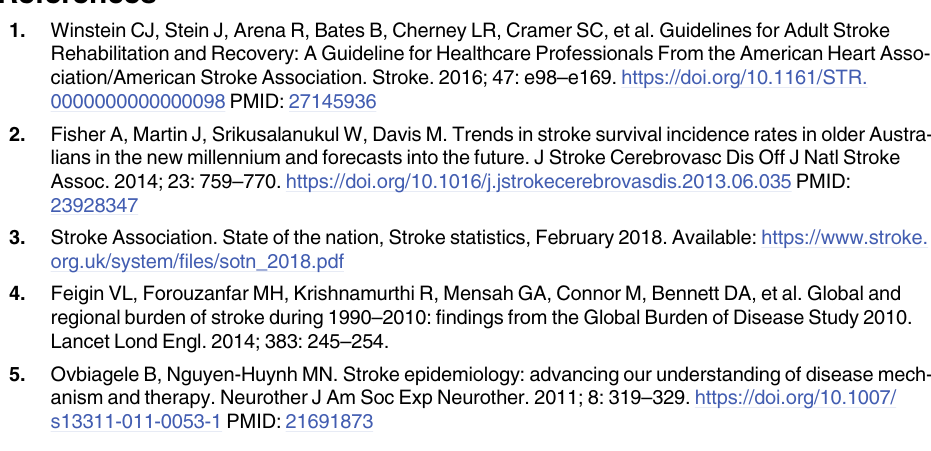
S1 Table. Search strategy. S2 Table. Type of intervention. S3 Table. List of reviews, interventions and trials that contributed to the overview. S4 Table. Characteristics of included reviews. S5 Table. Overview of reviews. S6 Table. Prisma 2009